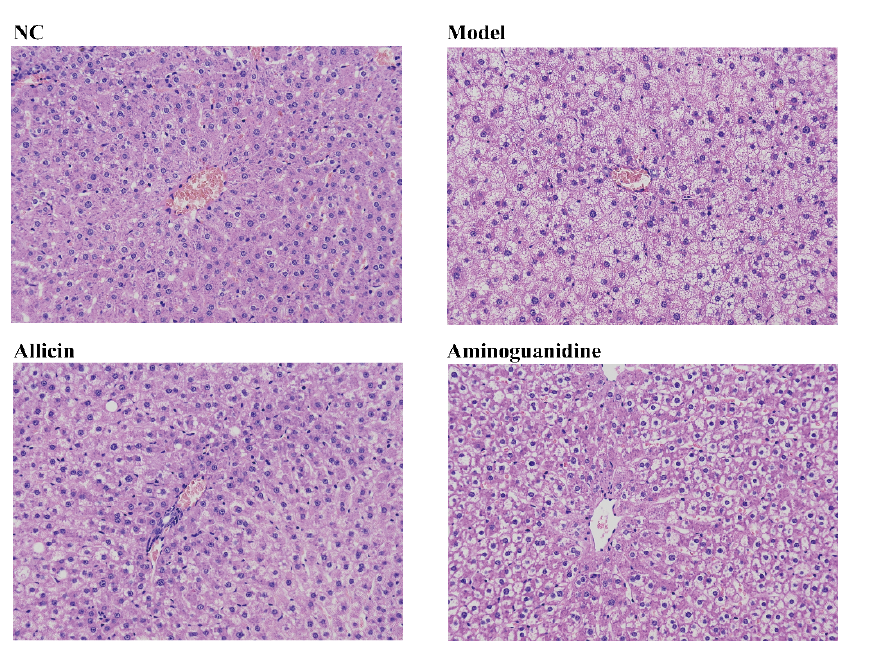
Figure 2. Allicin reduced liver lipid accumulation in diabetic rats. The drugs were administered at the end of the 7th week of the experiment, with a 6-week dosing cycle. The experiment ended at the 13th week, and the rats were sacrificed at the same time.